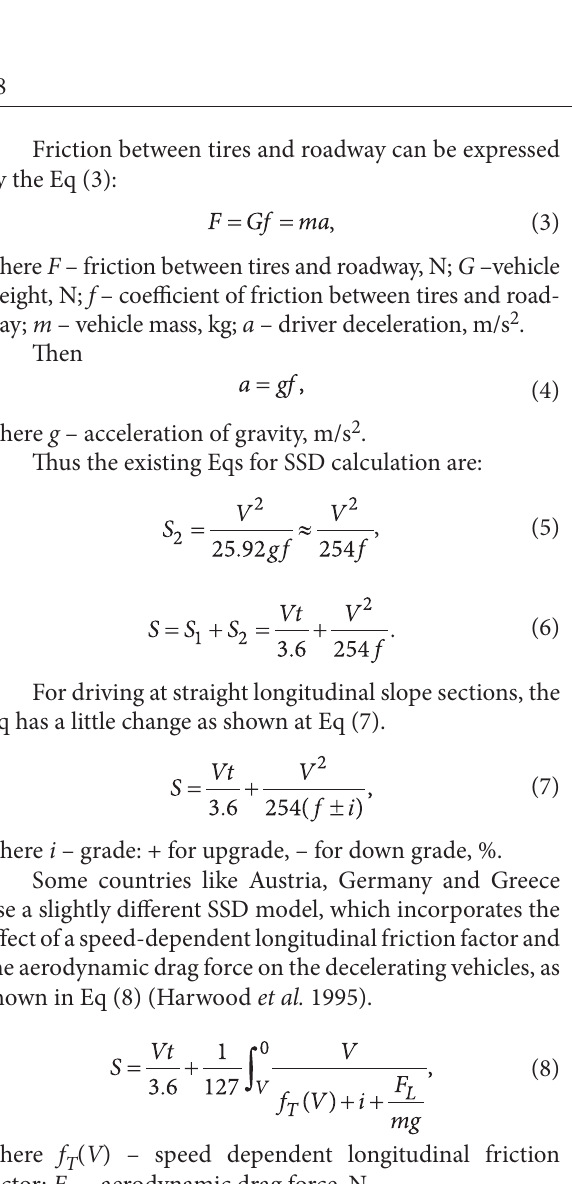
Fig. 3. Traveling at curve section, where above: a 0 – accele ra- tion centripetal, m/s 2 ; a – driver deceleration, m/s 2